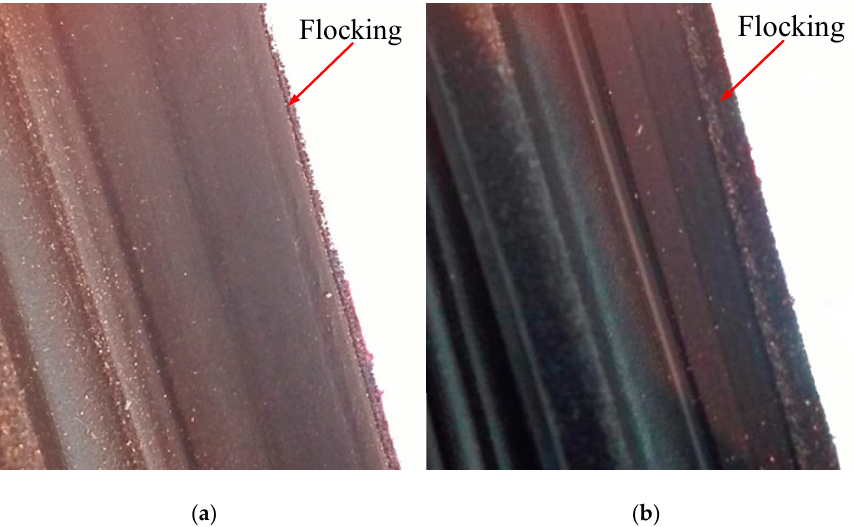
Figure 23. Flocking location map of inner belt. ( a ) Flocking position before improvement; ( b ) improved flocking location.